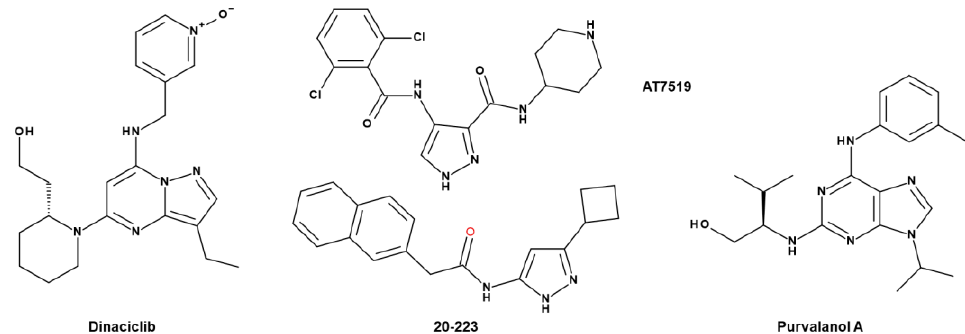
Figure 5. Structures of CDK5 inhibitors: roscovitine, flavopiridol, dinaciclib, olomoucine, purvalanol A, indurubin-3′, 20 -223, AT7519.